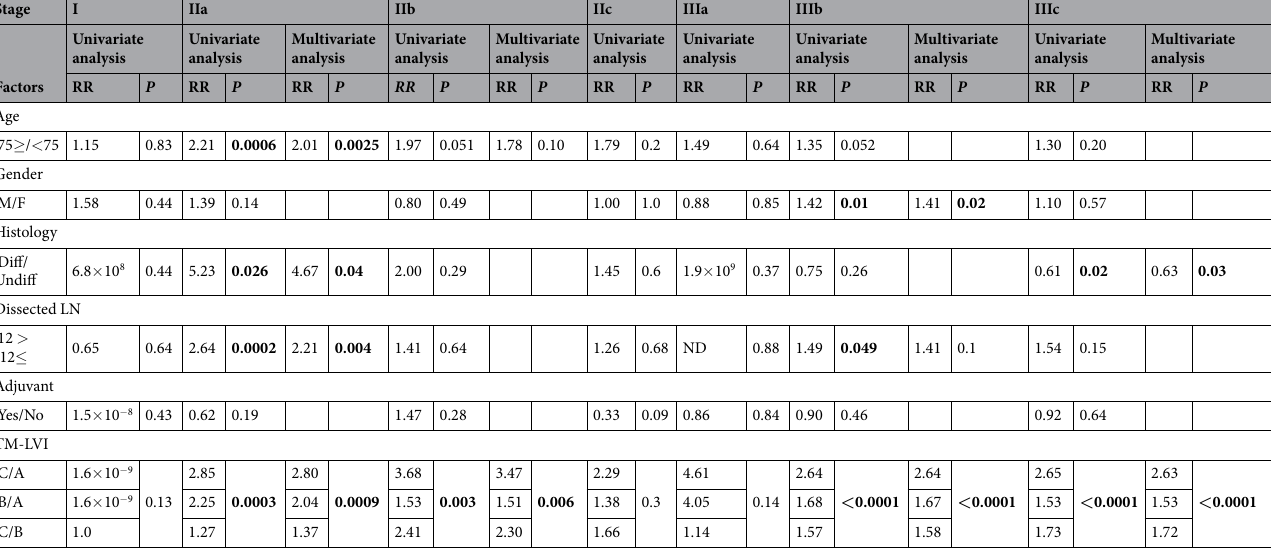
Table 4. Univariate and multivariate analysis for disease specific survival of colon cancer was performed in each clinical stage. TM-LVI was an independent prognostic factor for relapse-free survival of colon cancer in stage IIa, IIb, IIIb, and IIIc. M/F, Male/Female; Diff/Undiff, Differentiated/Undifferentiated; LN, Lymph node; RR, Risk ratio; Bold type, P <